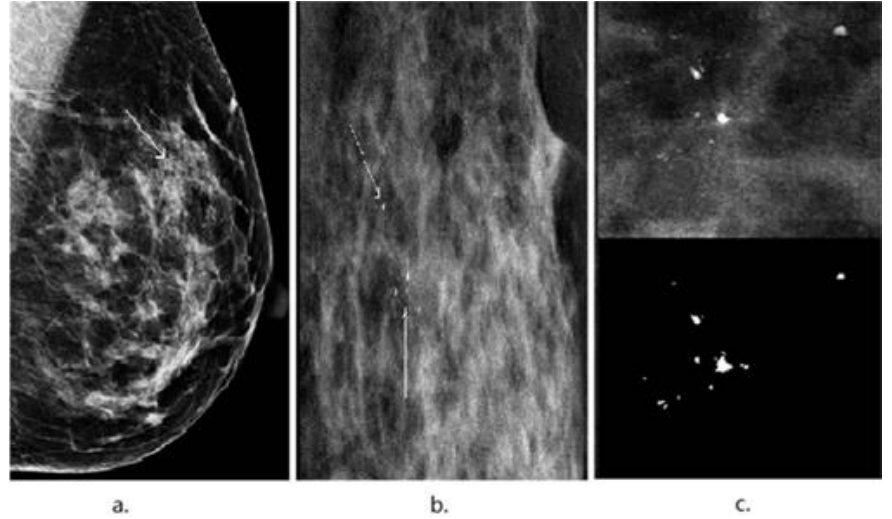
Figure 3. An illustrative example showing segmentation of microcalcifications in a mammogram of the right breast of a 49-year-old patient with fibrocystic changes. ( a ) The focal microcalcifications (indicated by thin arrows) appear as low contrast compared with the dense background in the mediolateral oblique (MLO) view. ( b ) Thin arrows indicate the region of suspicious microcalcifications. ( c ) A zoomed-in view of ( b ) highlights the segmented microcalcifications.